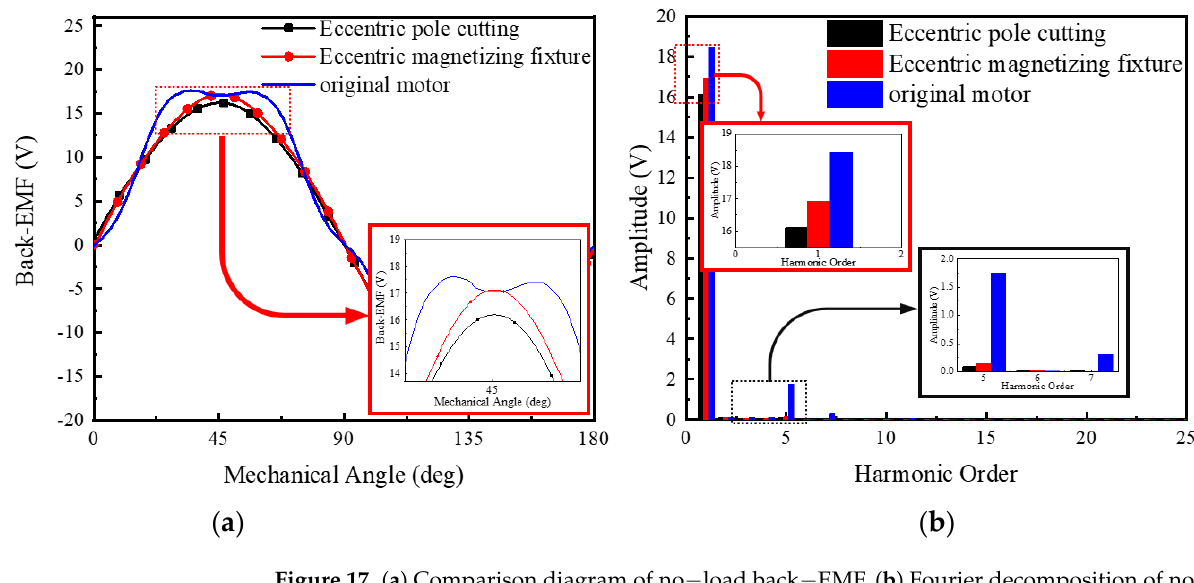
Figure 17. ( a ) Comparison diagram of no−load back−EMF . ( b ) Fourier decomposition of no−load back−EMF .